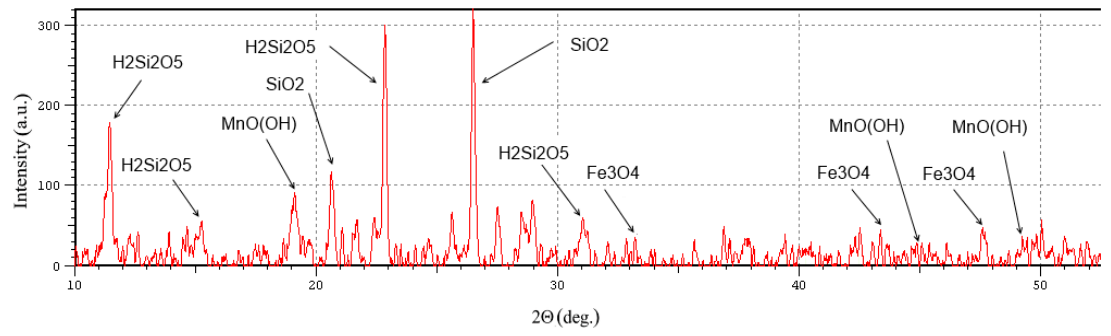
Figure 7. Results of X-ray phase analysis of ore samples after contact with gas.